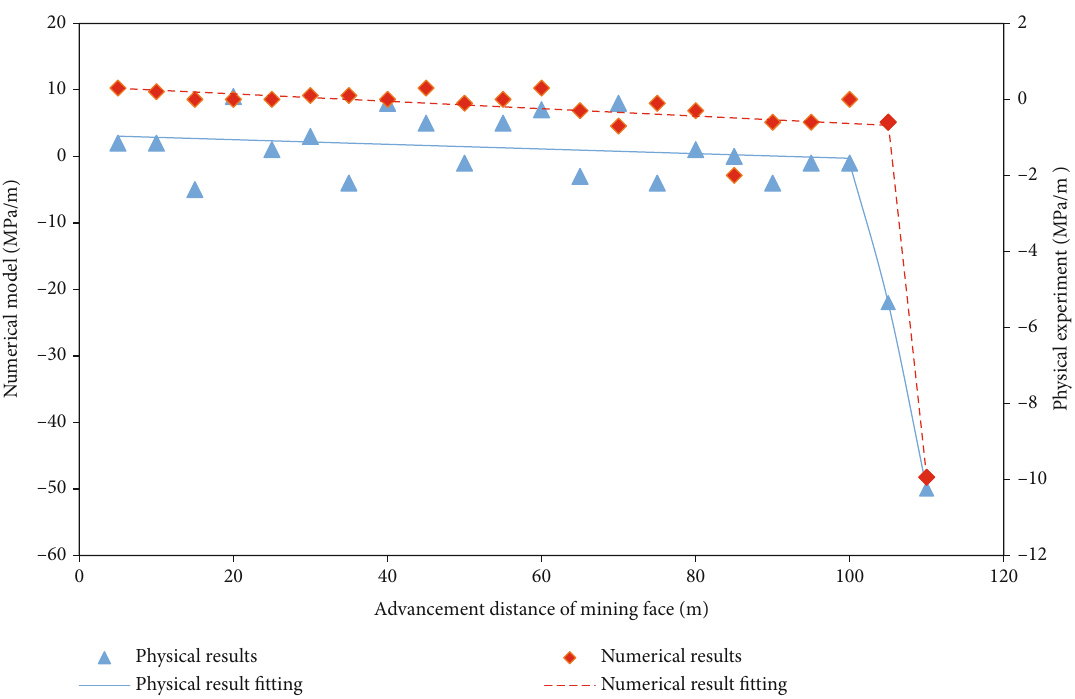
Figure 14: The stress comparison between numerical simulation and physical